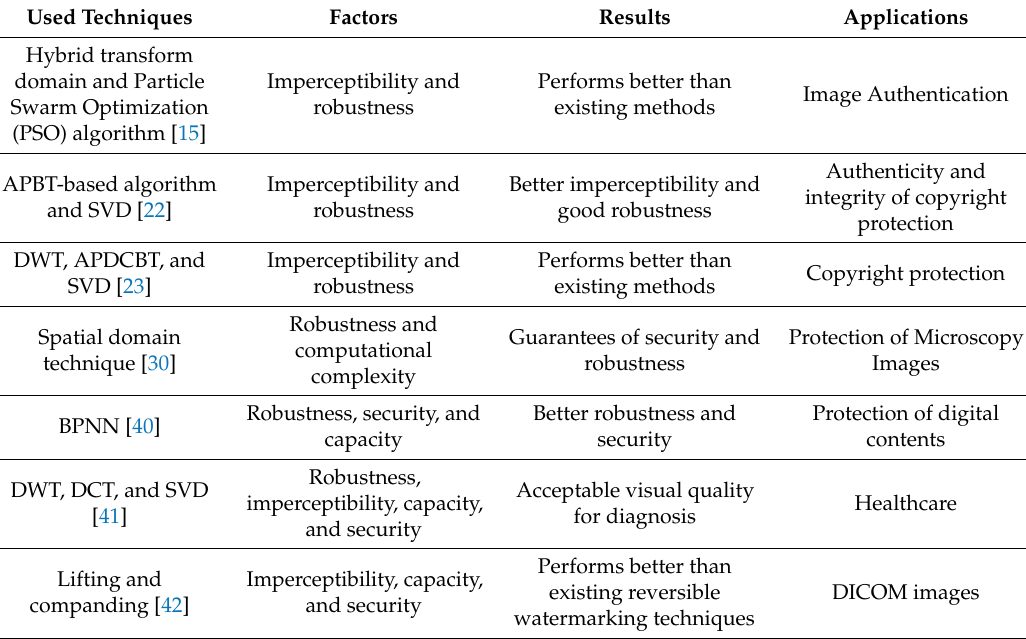
Table 1. Techniques that meet some requirements simultaneously.